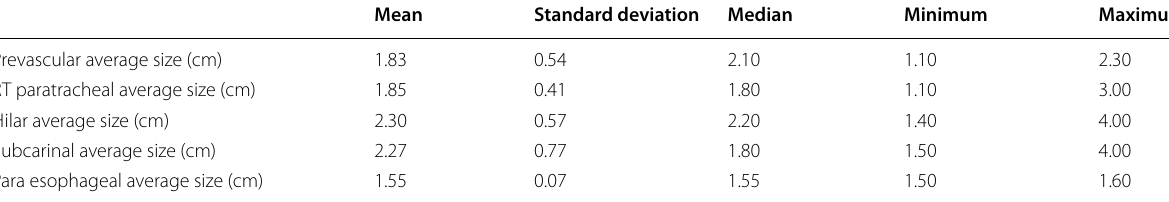
Table 2 Size of the mediastinal lymph nodes in each group